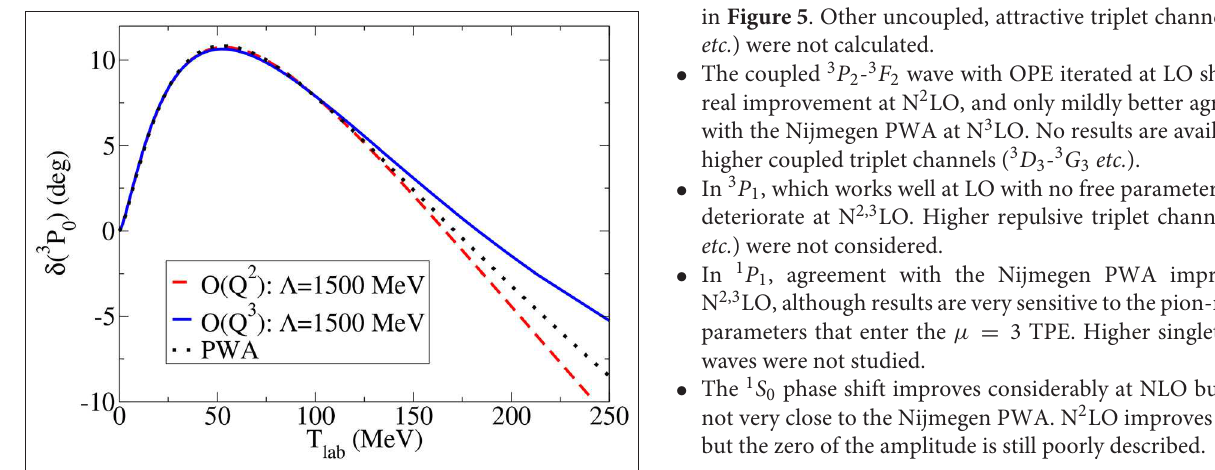
FIGURE 6 | Two-nucleon 3 P 0 phase shift δ ( 3 P 0 ) as function of the laboratory energy T lab . The N 2 LO (red dashed line) and N 3 LO (blue solid line) results at a cutoff 3 1.5 GeV are compared with the Nijmegen PWA [84] (black points). = Reprinted figure with permission from reference [104]. Copyright (2011) by the American Physical